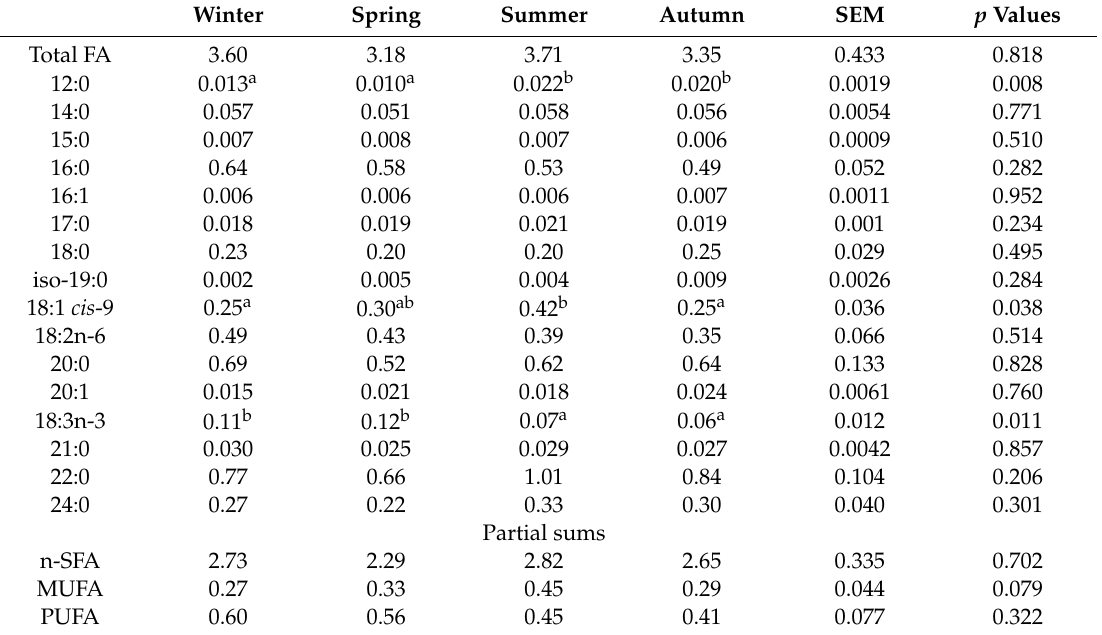
Table 2. E ff ect of season on fatty acid composition (mg / g DM) of C. ladanifer stems. Winter